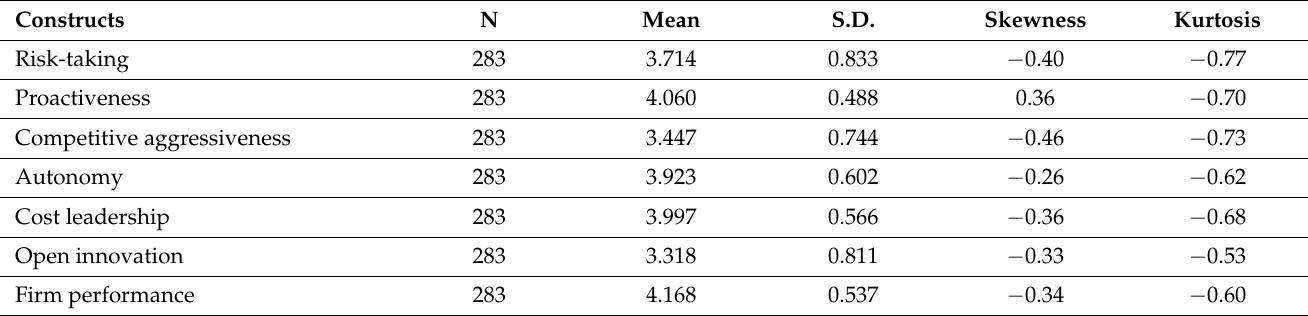
Table 2. Descriptive